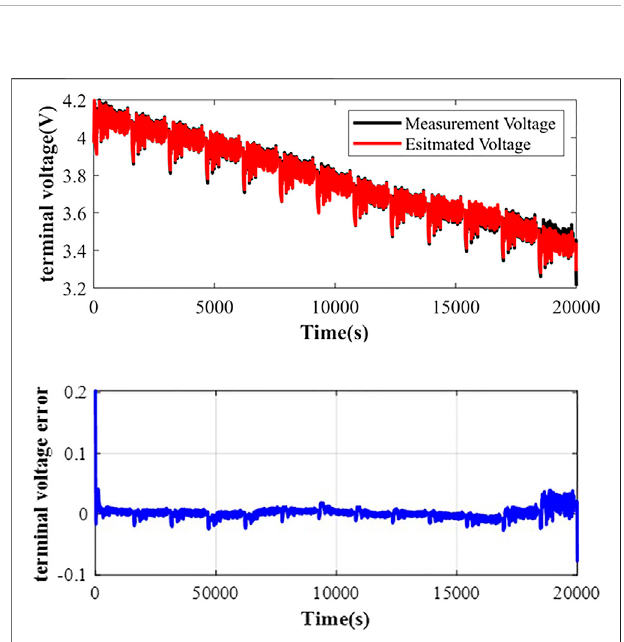
FIGURE 7 | Experimental terminal voltage results.